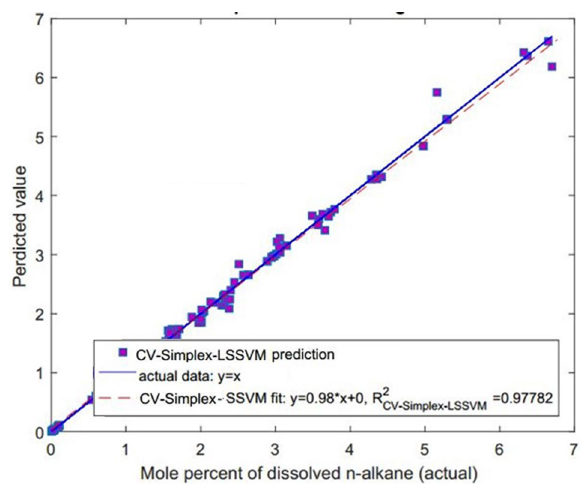
Fig. 3 CV-Simplex–LSSVM predicted mole percent of dissolved n -alkane for training